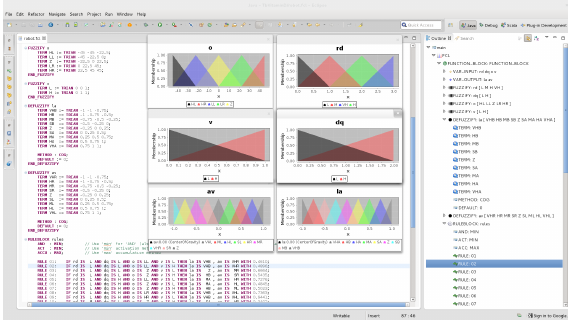
Fig. 10. jFuzzyLogic Eclipse pluging with robots.fcl ex- ample.